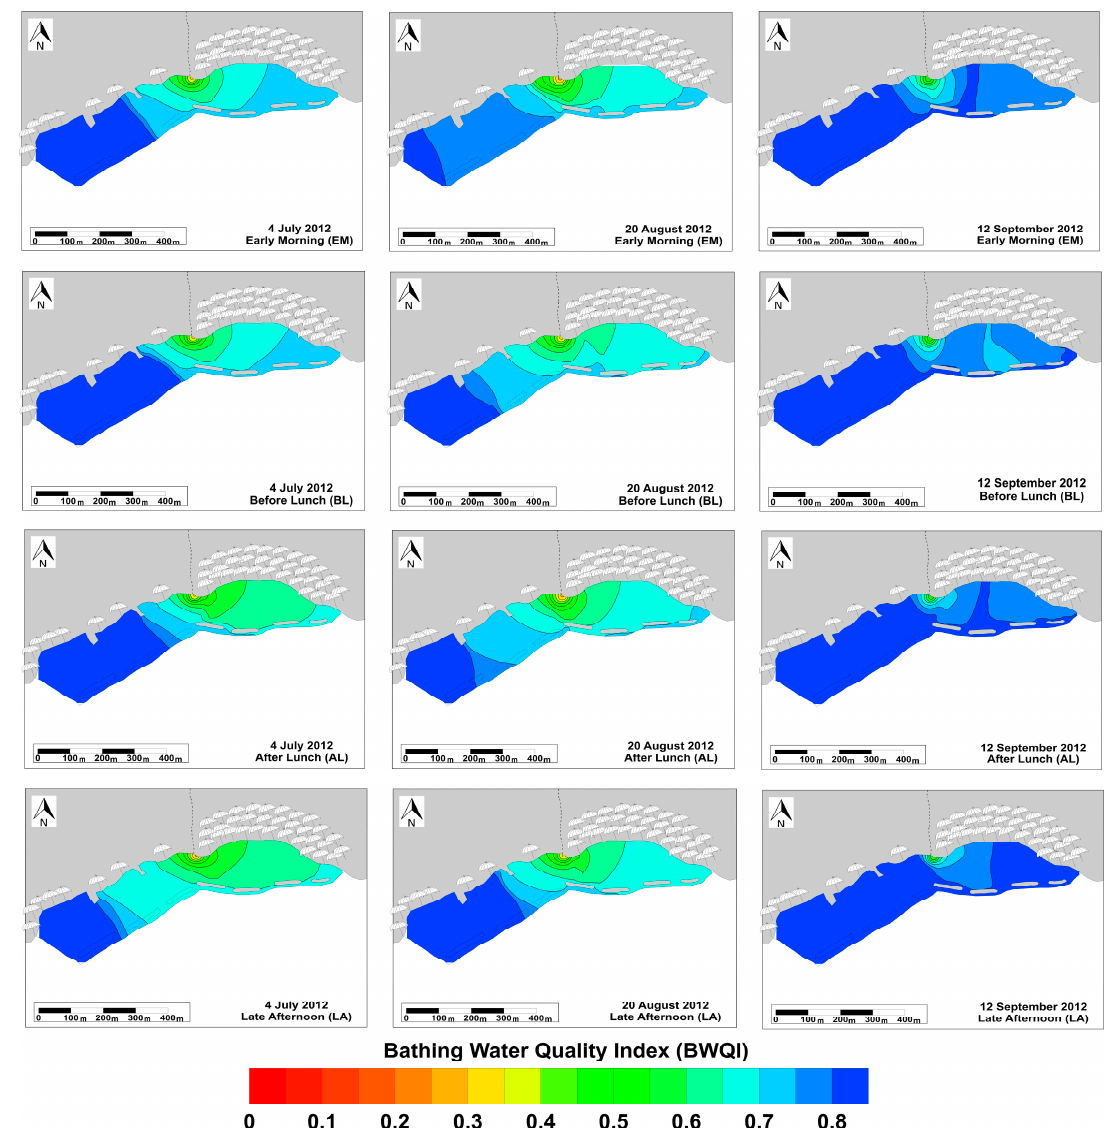
Figure 7. Spatial variation of the BWQI values within La Perla del Tirreno bathing area, reported in the three sampling days of summer 2012 (July, August, September, in columns) and in the four daily time periods (in rows).